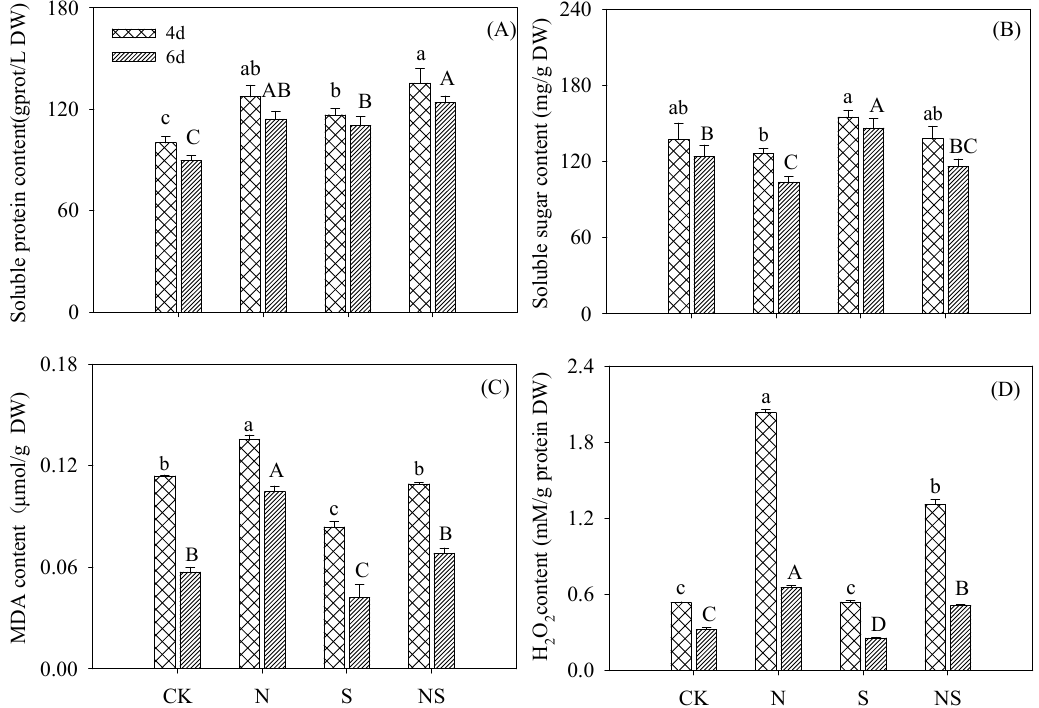
Figure 2. Changing pattern of ( A ) soluble protein content, ( B ) soluble sugar content, ( C ) malonaldehyde (MDA) content, and ( D ) H 2 O 2 content in germinating soybeans. Lowercase letters reflect the significance of differences in index among treatments of 4-day germinating soybeans and capital letters reflect the significance of differences in index among treatments of 6-day germinating soybeans ( p < 0.05). CK, Control; N, NaCl; S, Spd; NS, NaCl + Spd.